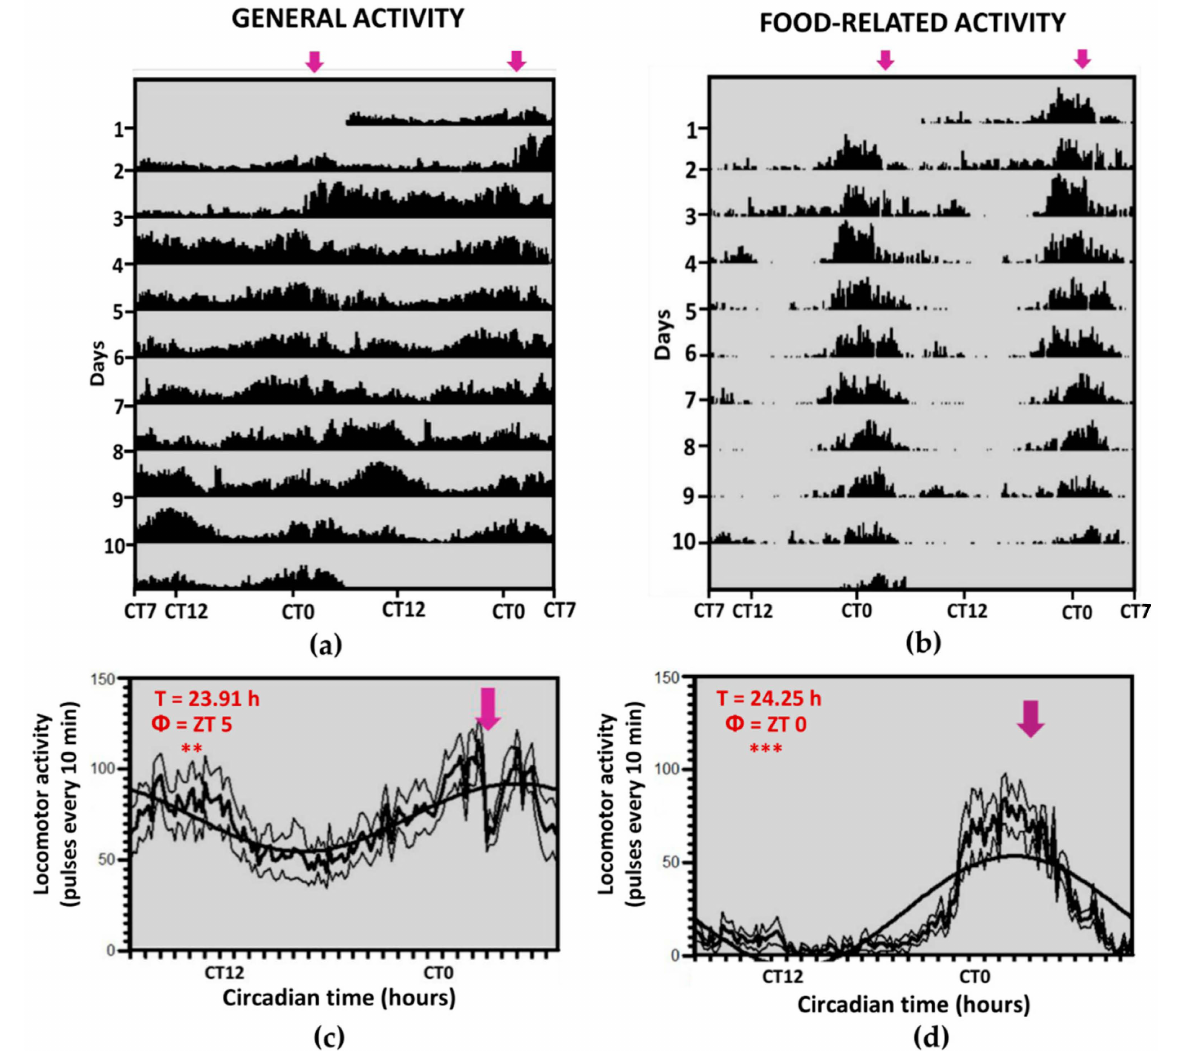
Figure 3. Locomotor activity (general ( a , c ) and food-related ( b , d )) for group DD-2, under constant darkness and fixed feeding. The shaded zones indicate the darkness period. ( a , b ): double-plot actograms, in which the X-axis represents the time of the day of two consecutive days, and the Y-axis represents the days on which activity was registered. ( c , d ): Average waveform of locomotor activity (same data). Data are expressed as mean ± SEM. Acrophase ( φ ) and significance of the Rayleigh test for a 24-h rhythm are shown ** p < 0.01, *** p < 0.001. T = rhythm period (when significant) according to Sokolove–Bushell